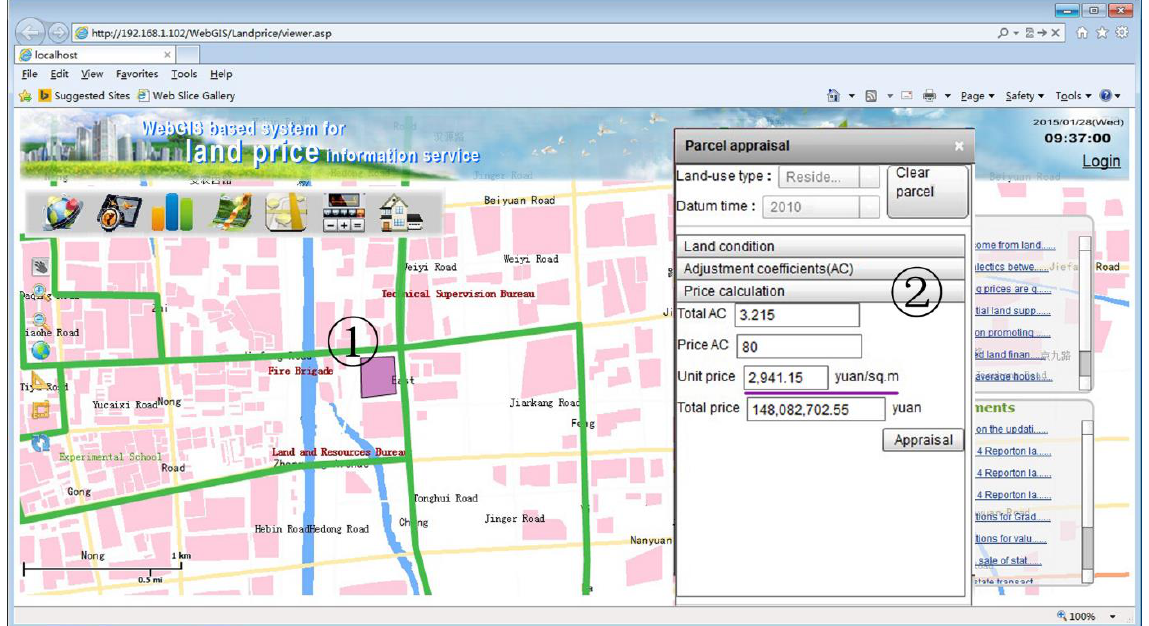
Figure 6. An example of using pracel appraisal